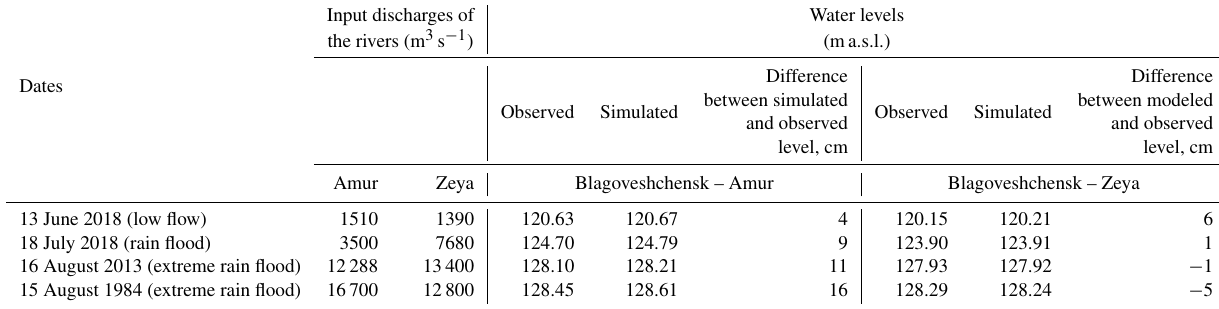
Table 1. Comparison of water levels for validation scenarios. Input discharges of Water levels the rivers (m 3 s − 1 ) (ma.s.l.) Difference Difference Dates between simulated between modeled Observed Simulated Observed Simulated and observed and observed level, cm level, cm Amur Zeya Blagoveshchensk – Amur Blagoveshchensk –